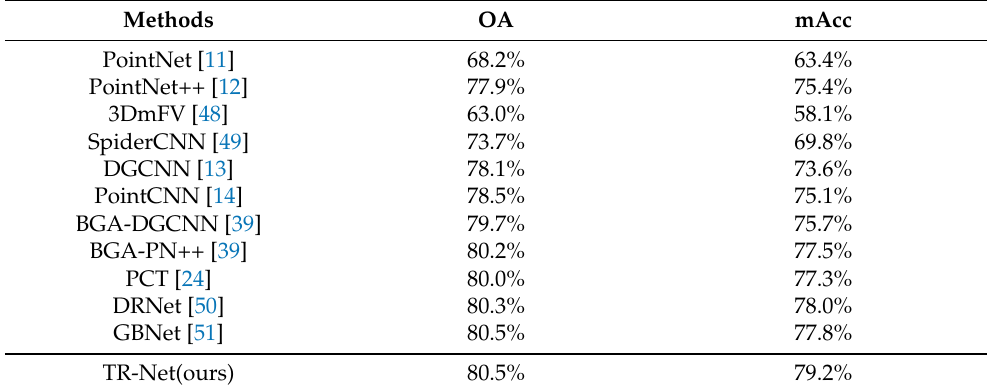
Table 4. Classification results on ScanObjectNN